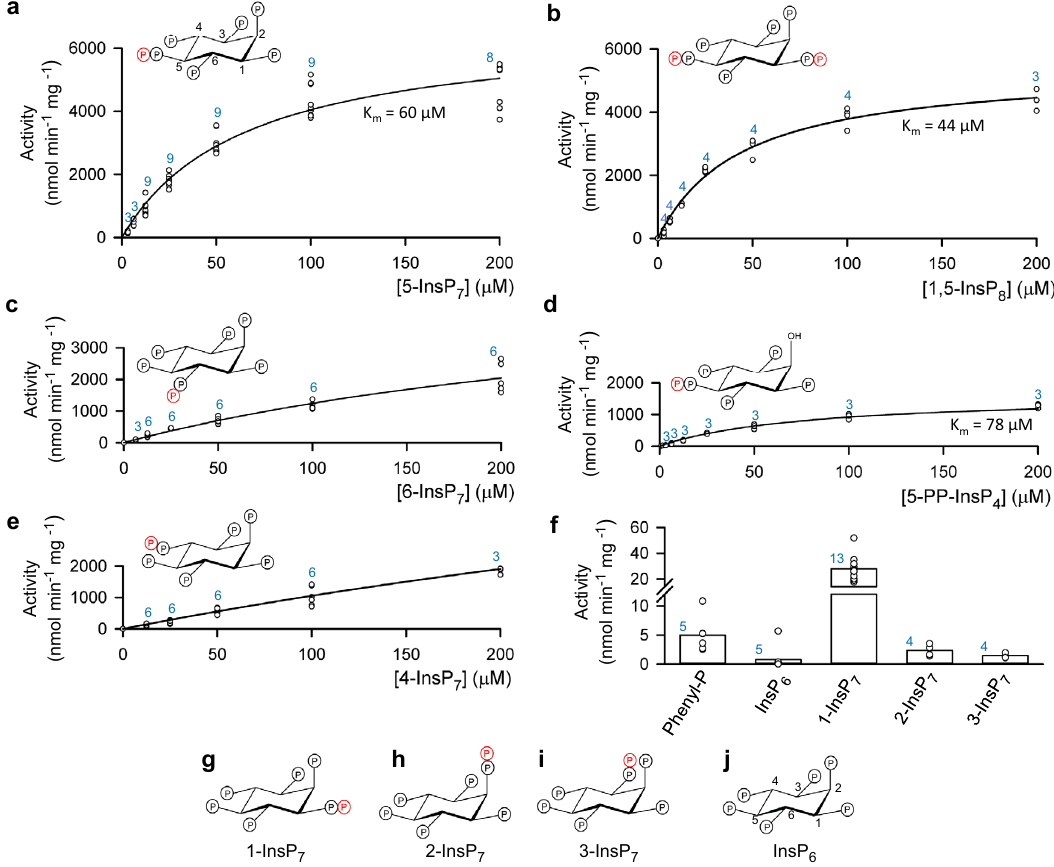
Fig. 1 Structures of ligands used in this study and their rates of hydrolysis by At PFA-DSP1. Michaelis – Menten kinetic plots are shown for the phosphatase activities of At PFA-DSP1 towards: ( a ), 5-InsP 7 , ( b ), 1,5-InsP 8 , ( c ), 6-InsP 7 , ( d ), 5-PP-InsP 4 and ( e ), 4-InsP 7 . Activity data (circles, some overlapping) are from each independent experiment at which the indicated substrate concentration was tested; the total number of such experiments is given above each data set in blue font. K m values were calculated when statistically appropriate. The insets in panels ( a – e ) depict chair conformations of each substrate; the positions of each β -phosphate are emphasized in red. In panel ( f ), vertical bars represent mean values of activities against the weakest substrates when all were assayed at 10 µ M concentrations. Activity data (circles, some overlapping) are from each independent experiment; the total number of such experiments is given above each data set in blue font. Phenylphosphate is abbreviated as Phenyl-P. Structures of the inositol phosphates are given as chair conformations in panels ( g ) (1-InsP 7 ), ( h ) (2-InsP 7 , ( i ) (3-InsP 7 ) and ( j ) (InsP 6 ). Locants (using standard nomenclature for myo -inositol) are provided with the structures of 5-InsP 7 and InsP 6 . Source data are provided as a Source Data fi